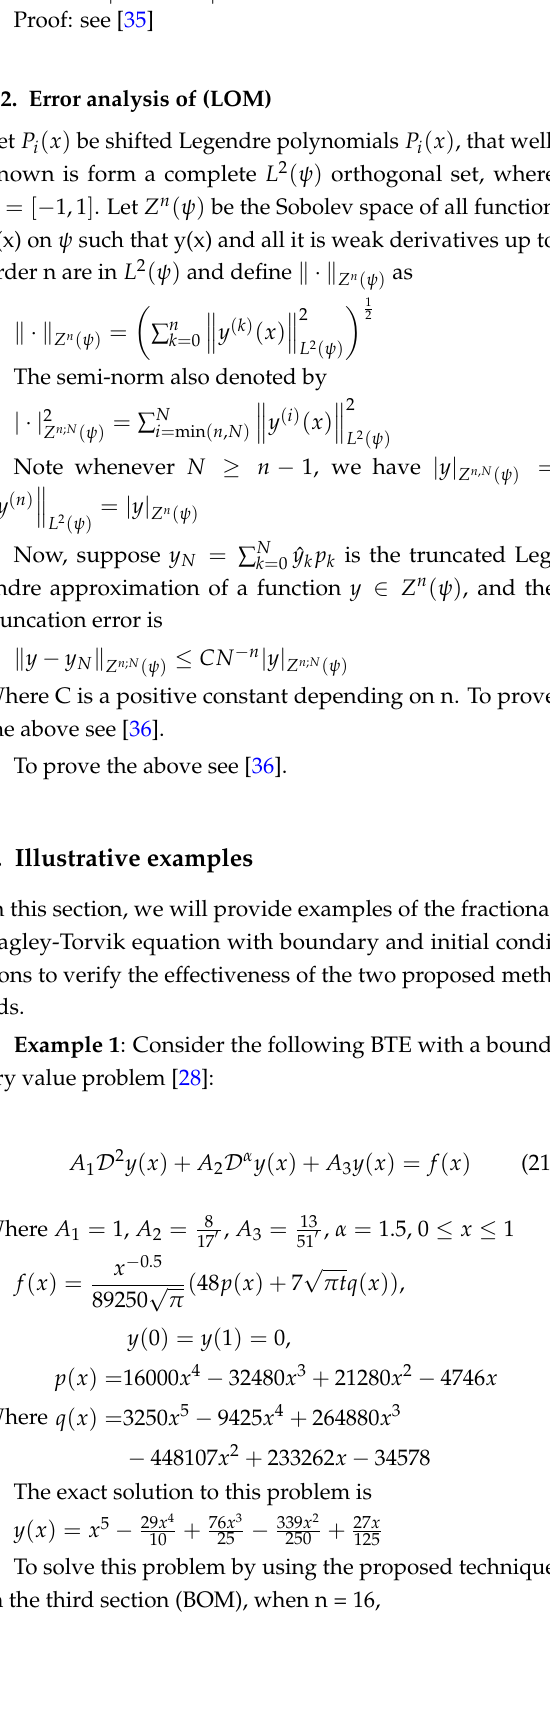
(cid:12) (cid:12) y exact − y approximate